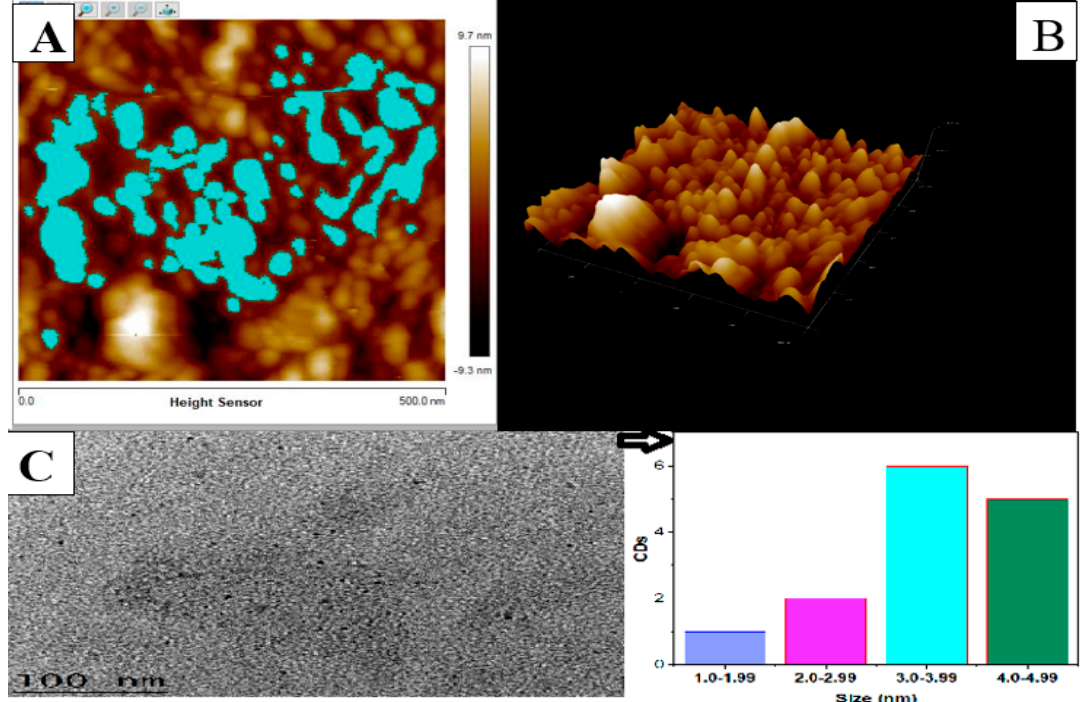
Figure 2. ( A ) atomic force microscopy (AFM) 2D image of carbon dots (CDs) ( B ) AFM 3D morphology of CDs ( C ) high resolution transmission electron microscopic (HrTEM) image of CDs.